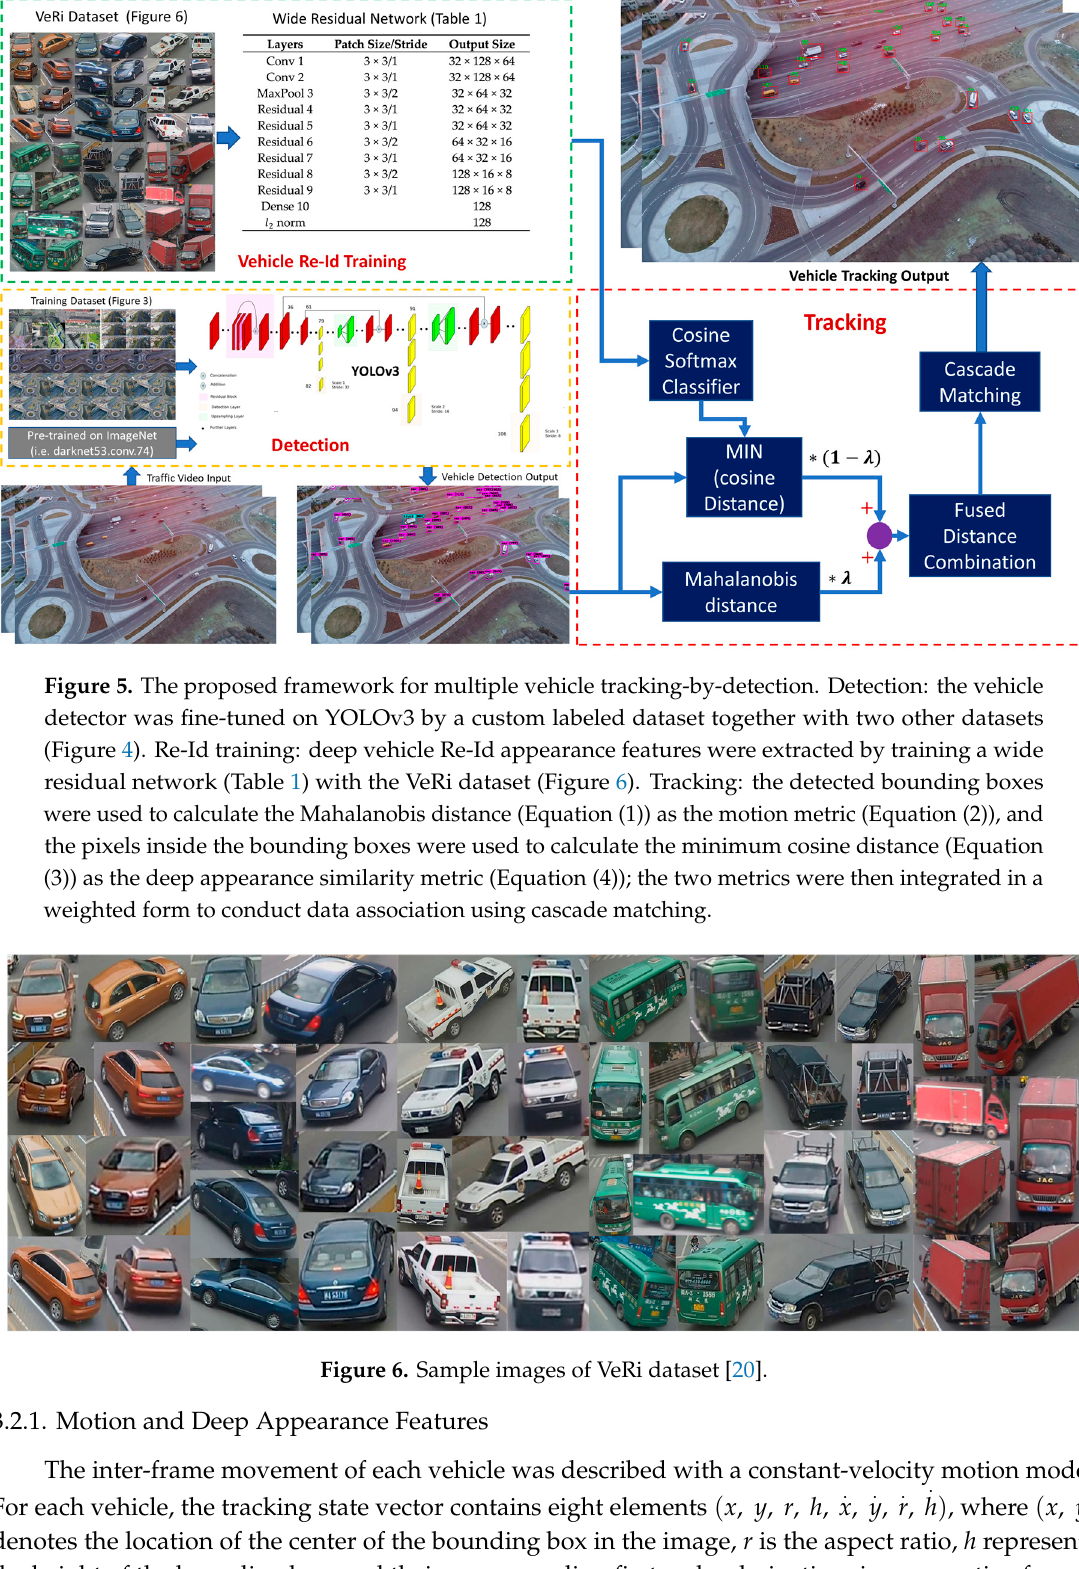
Figure 4. Datasets used for fine-tuning YOLOv3 vehicle detector: ( a ) 155 images from aerial-cars- dataset; ( b ) 1374 images from the UAVDT-Benchmark (M0606); ( c ) 157 images from our UAV videos (DJI_0004 and DJI_0016).